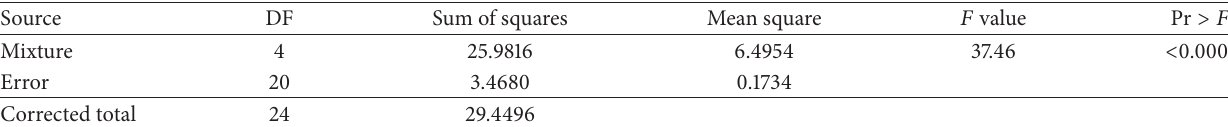
Table 5: Analysis of variable result for the indirect tensile strength.